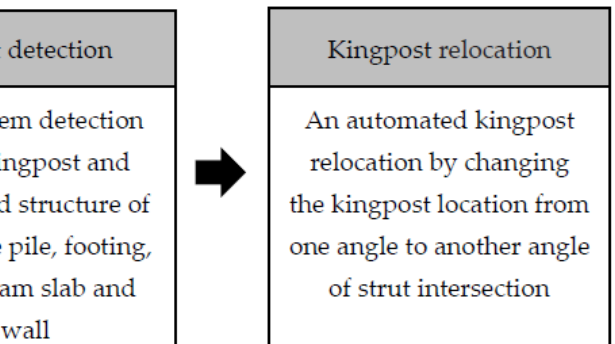
1.70 Figure 9. Types of kingposts in Thailand. 4.3. System Development After collecting the information support of the kingpost arrangement, this infor- mation needed to develop into the module of the system. There were three main stages of developed system. First, the module was initially developed for generating the initial